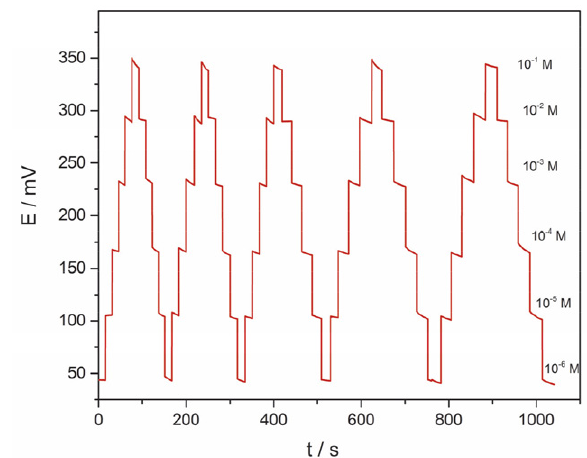
Figure 5. Repeatability measurements of the DOP-selective mi- crosensor